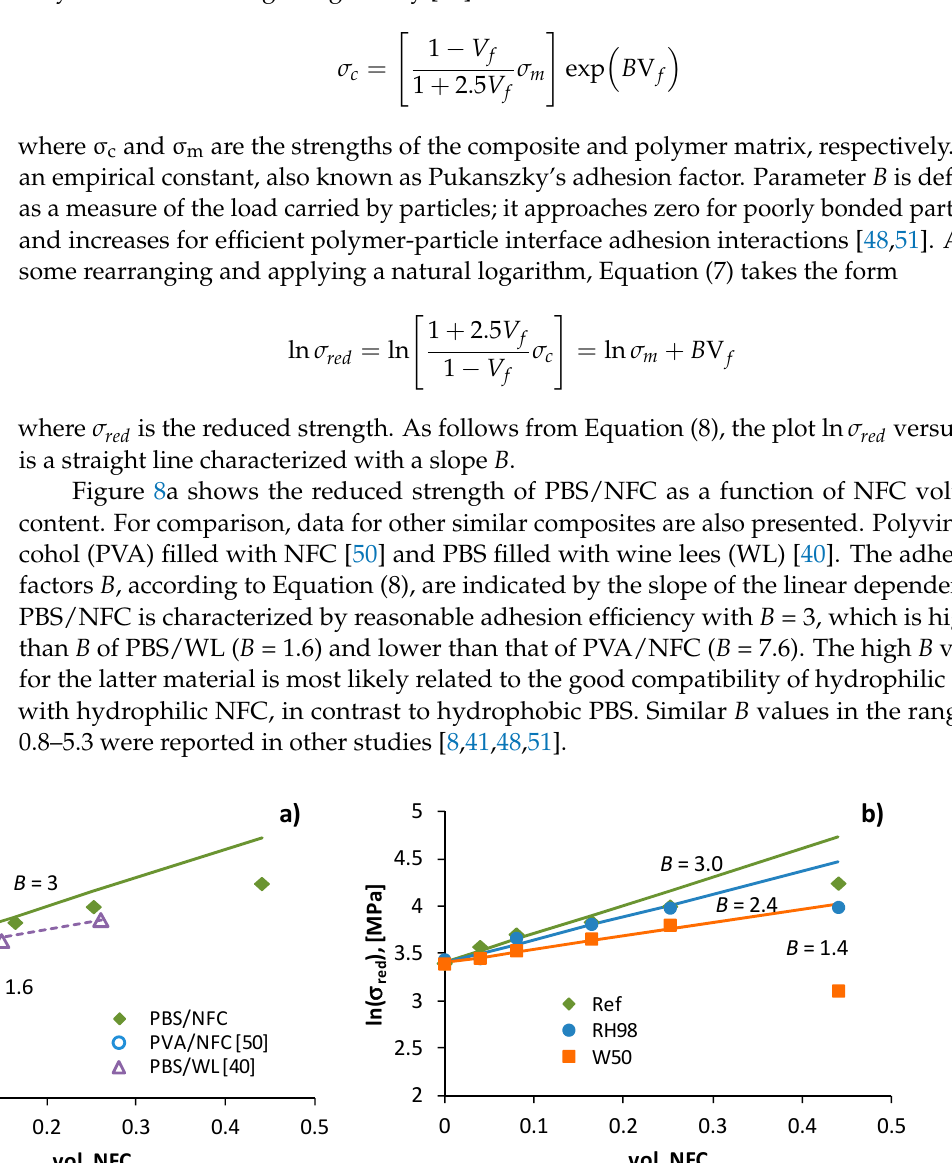
Figure 7. Strength versus elastic modulus of PBS/NFC reference and aged samples.